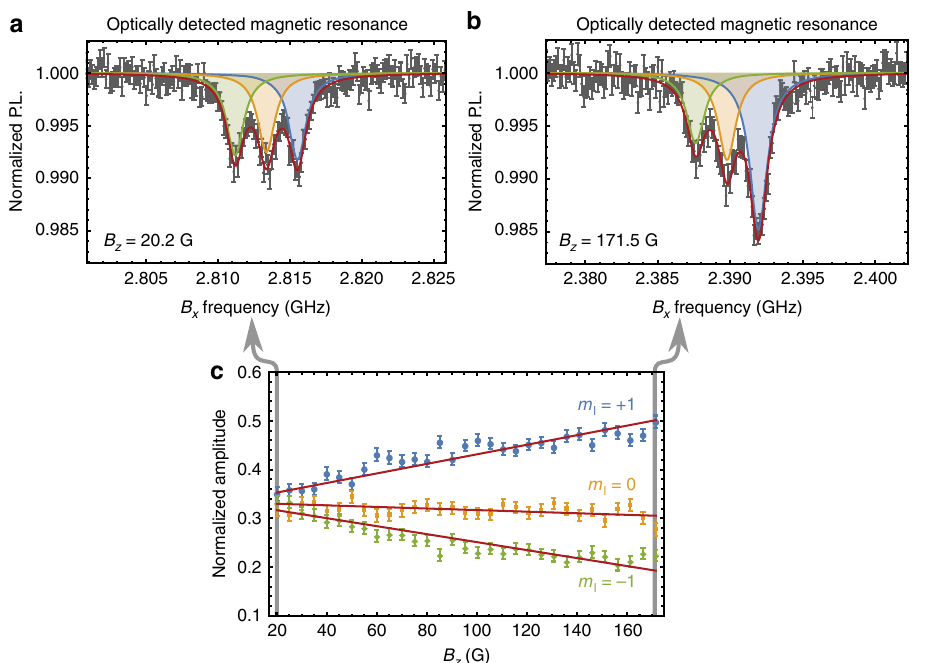
Figure 5 | Calibrating B z -dependent nuclear polarization. ( a , b ) Normalized photoluminescence (P.L.) plotted as a function of the magnetic driving field carrier frequency for ( a ) B z ¼ 20.2G and ( b ) B z ¼ 171.5G. The solid line in each plot is a least squares fit to the sum of three Lorentzians. The data in a , b was measured on a single device with an NV centre ensemble, and error bars are from the s.d. in photon counting. ( c ) Normalized amplitude of each m I hyperfine sublevel as a function of B z . The solid lines are least squares fits to a linear model, each point corresponds to a single measurement, and error bars are standard error from the